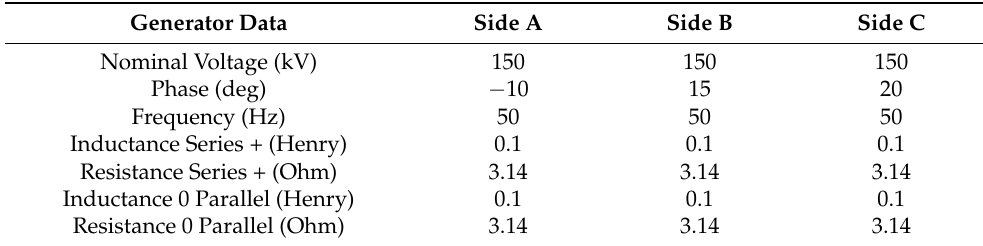
Figure 17. Submarine transmission system used for testing the IIA Zone protection algorithm. Table 11. Generators’ data for submarine transmission